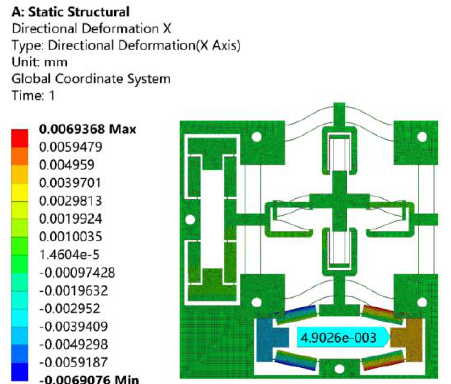
ff ness by ANSYS. Figure 12. Analysis of the input stiffness by ANSYS. Figure 12. Analysis of the input sti Figure 12. Analysis of the input stiffness by ANSYS.